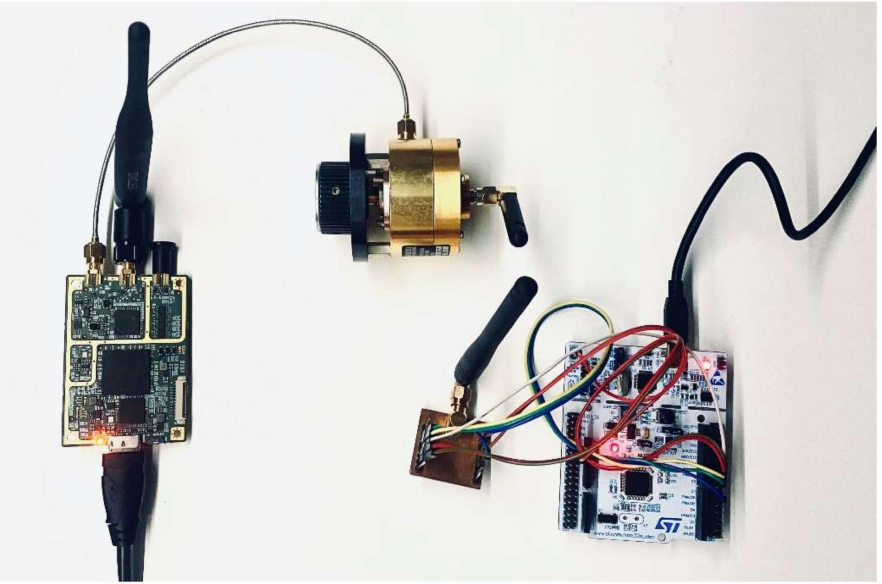
Figure 16. Measure stand: radio sensor and device for injecting disturbances and spectral observa- tions —USRP-B200mini with an attached adjustable